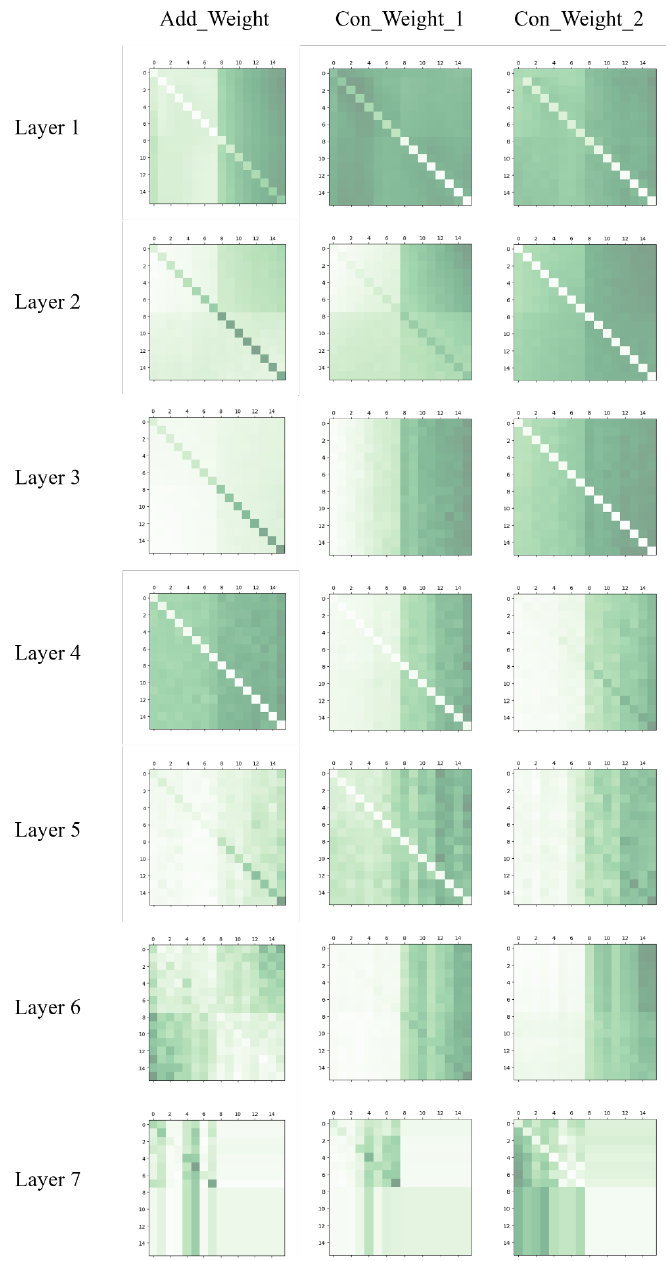
Figure A1. Visualization of the attention weight matrices. The first column is 𝑊 𝑎𝑑𝑑 obtained using Formula (16). The second and the third columns are 𝑊 1 and 𝑊 2 when using the second fusion method, which can be obtained using Formulas (13) and